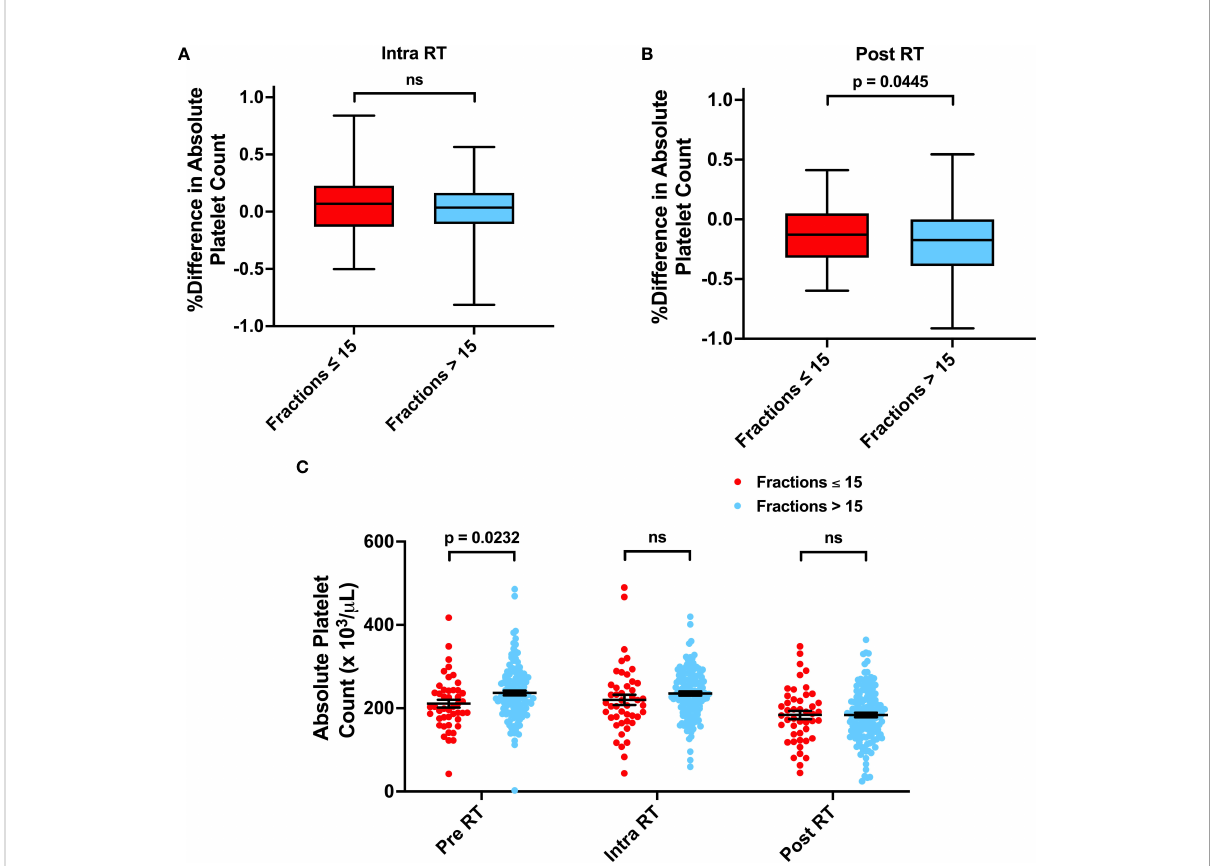
FIGURE 8 Associations between Number of Radiation Fractions and Platelet Counts. (A, B) Percent difference in platelet counts for patients receiving ≤ 15 or > 15 fractions from before radiation treatment (RT) to during RT or after RT. (C) Absolute platelet counts before, during, and after RT for patients receiving ≤ 15 or > 15 fractions. Statistical analysis was performed using two sample t-tests. ns, not signi fi